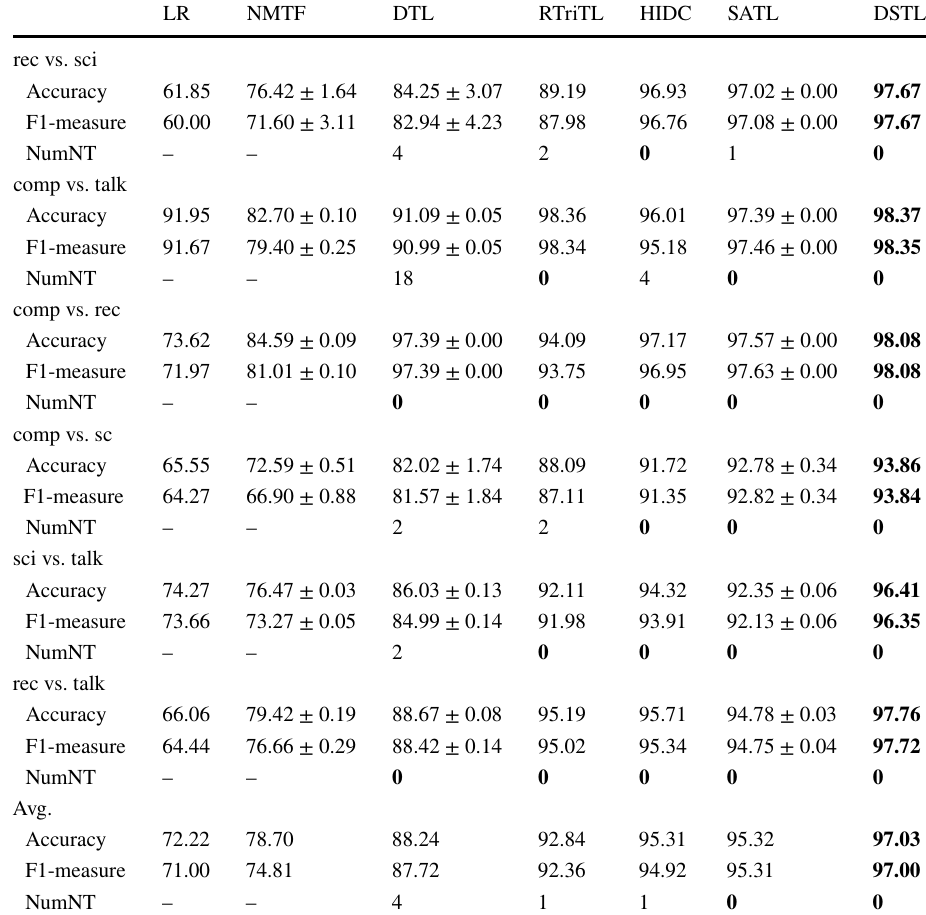
Table 5 Algorithm performance (%) on 20-Newsgroups tasks